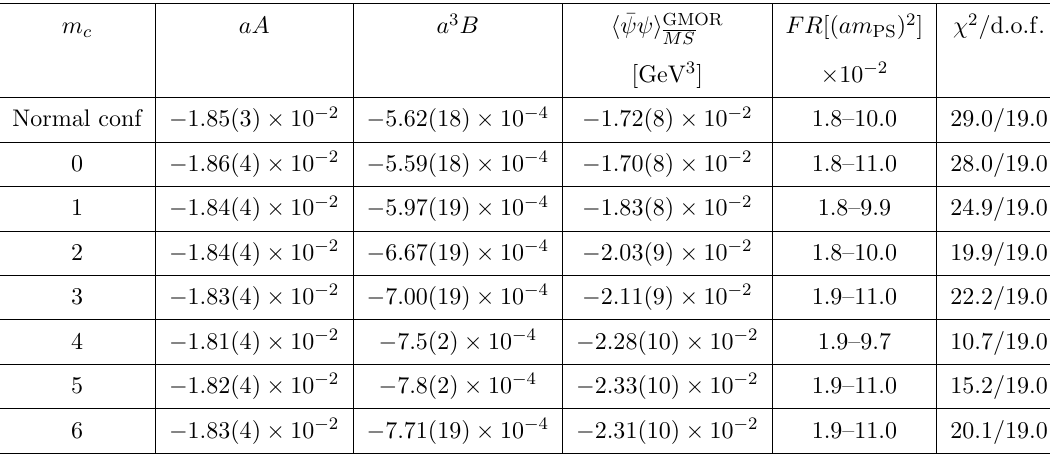
Table 13 . The results of the slope aA and intercept a 3 B obtained by (cid:12)tting the function (5.30). The results of the renormalized chiral condensate h (cid:22) i GMOR